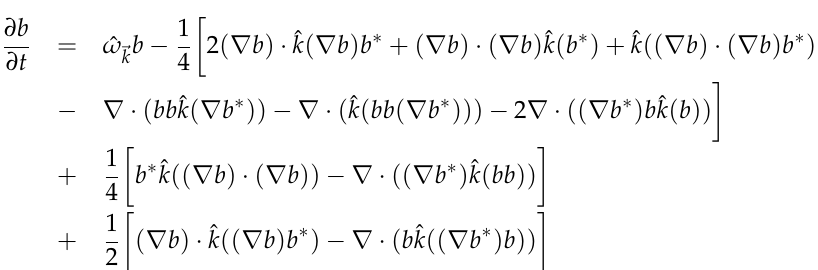
(cid:126) k (cid:126) k 2 , 3 Figure 1. Behavior of T in panel ( a ) and ˜ T (cid:126) k , (cid:126) k 1 curve has a circle corresponding to the x coordinate of point P . The circles form a curve for matching (cid:126) k , (cid:126) k 1 vectors T . The left part of the panels corresponds to P and P 2 which are in the same quadrant (cid:126) k , (cid:126) k 1 while the right part corresponds to the case wherein P and P 2 are in different